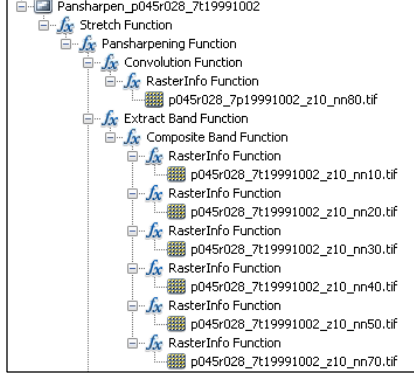
Figure 4 A raster function chain of the Pansharpen